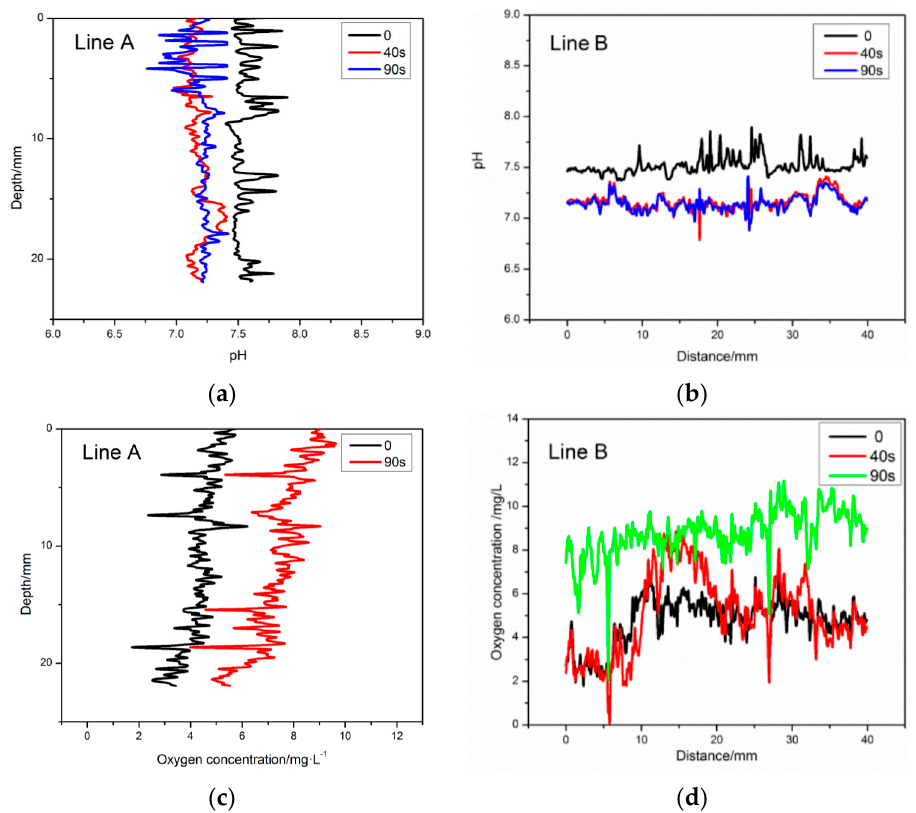
Figure 8. Extraction of time-resolved and depth-resolved dynamics from time series recording pH/oxygen distribution images in Figure 7. ( a , c ) The vertical and horizontal pH/oxygen profiles of Line A in Figure 7; ( b , d ) The horizontal pH/oxygen profiles of Line B in Figure 7.